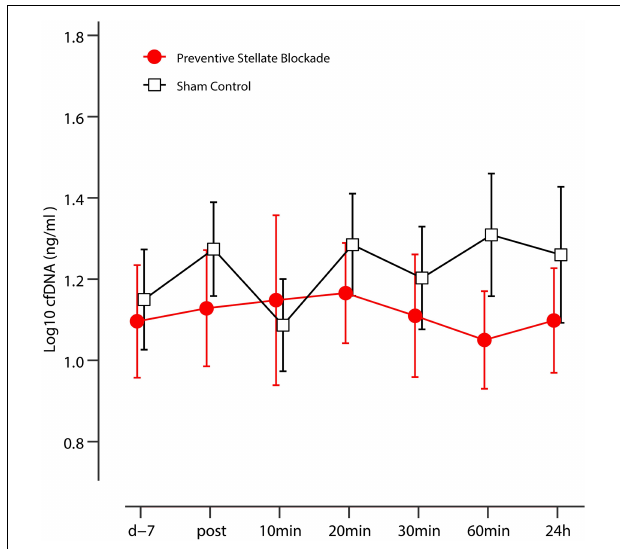
physiological stimuli with an overshooting pathological